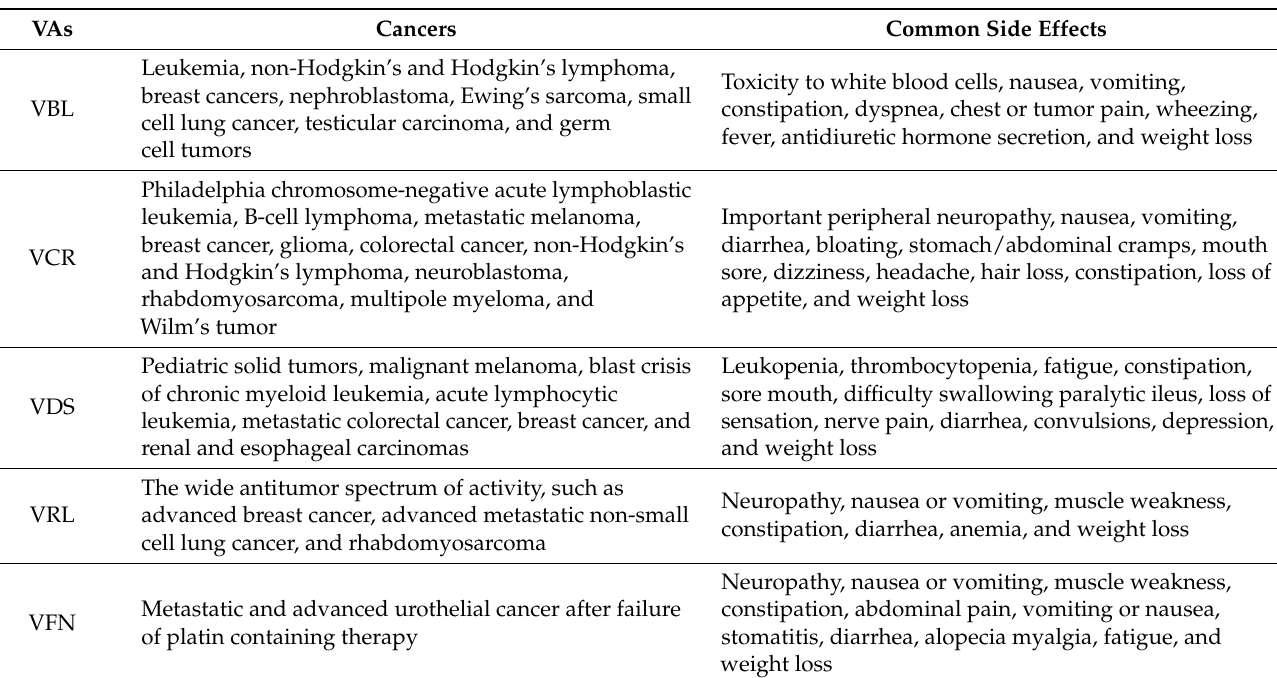
Table 1. Vinca alkaloids (VAs) and their applications in different treatments for cancers along with their most common side